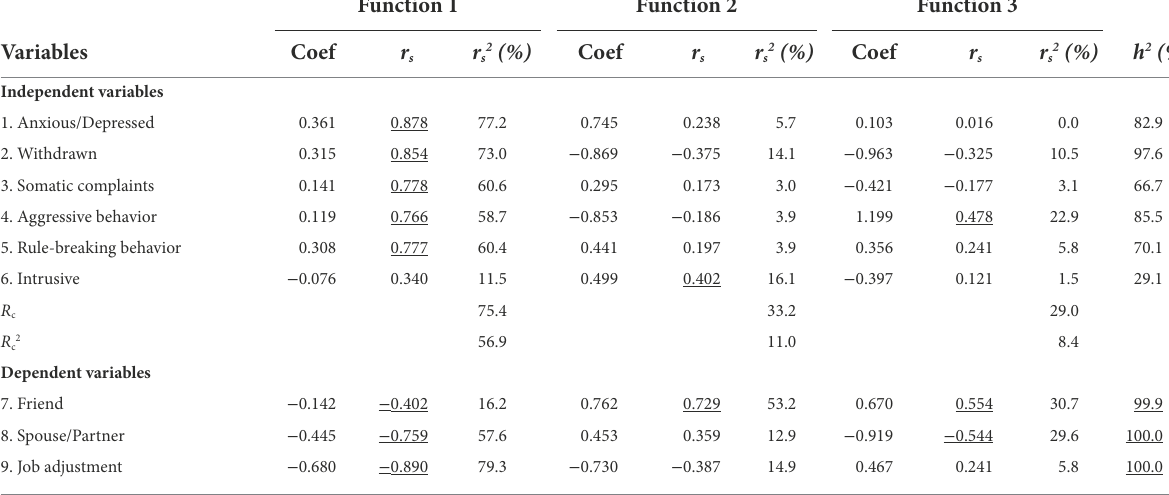
TABLE 2 Canonical solution for adaptive functioning predicting psychological